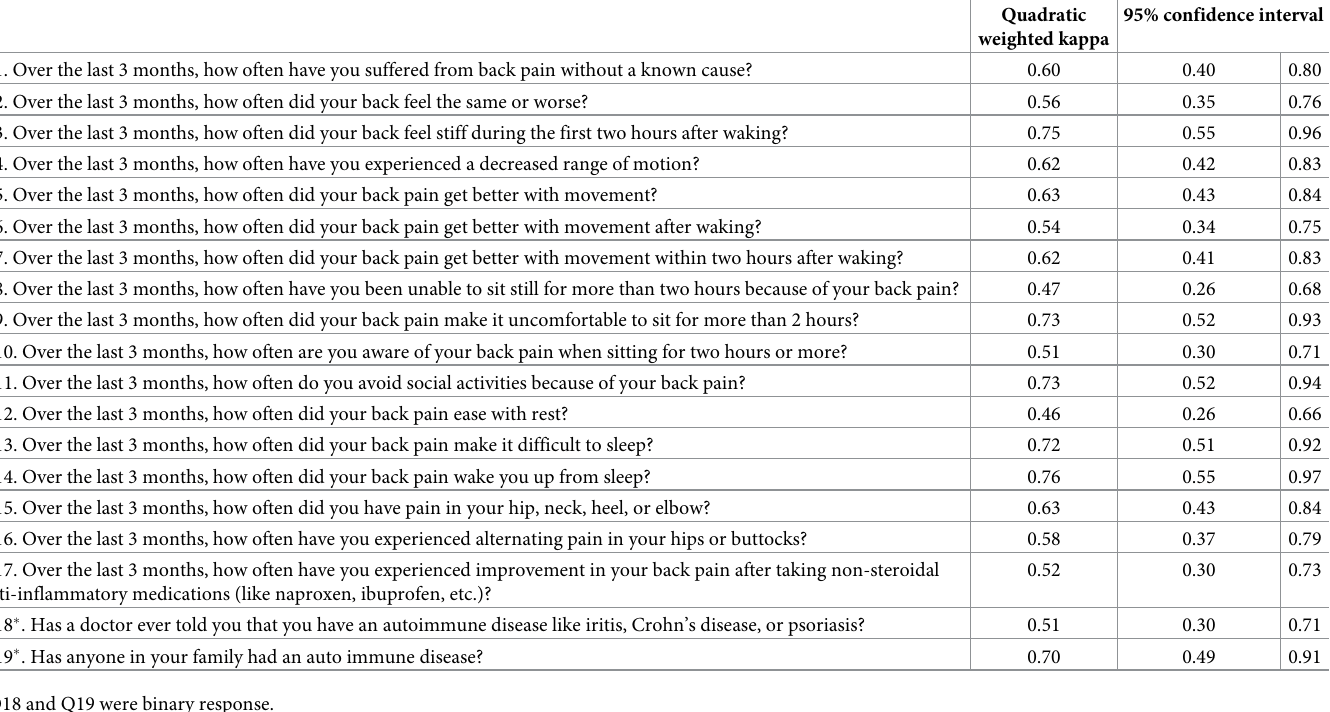
Table 2. Test-retest reliability of each proposed